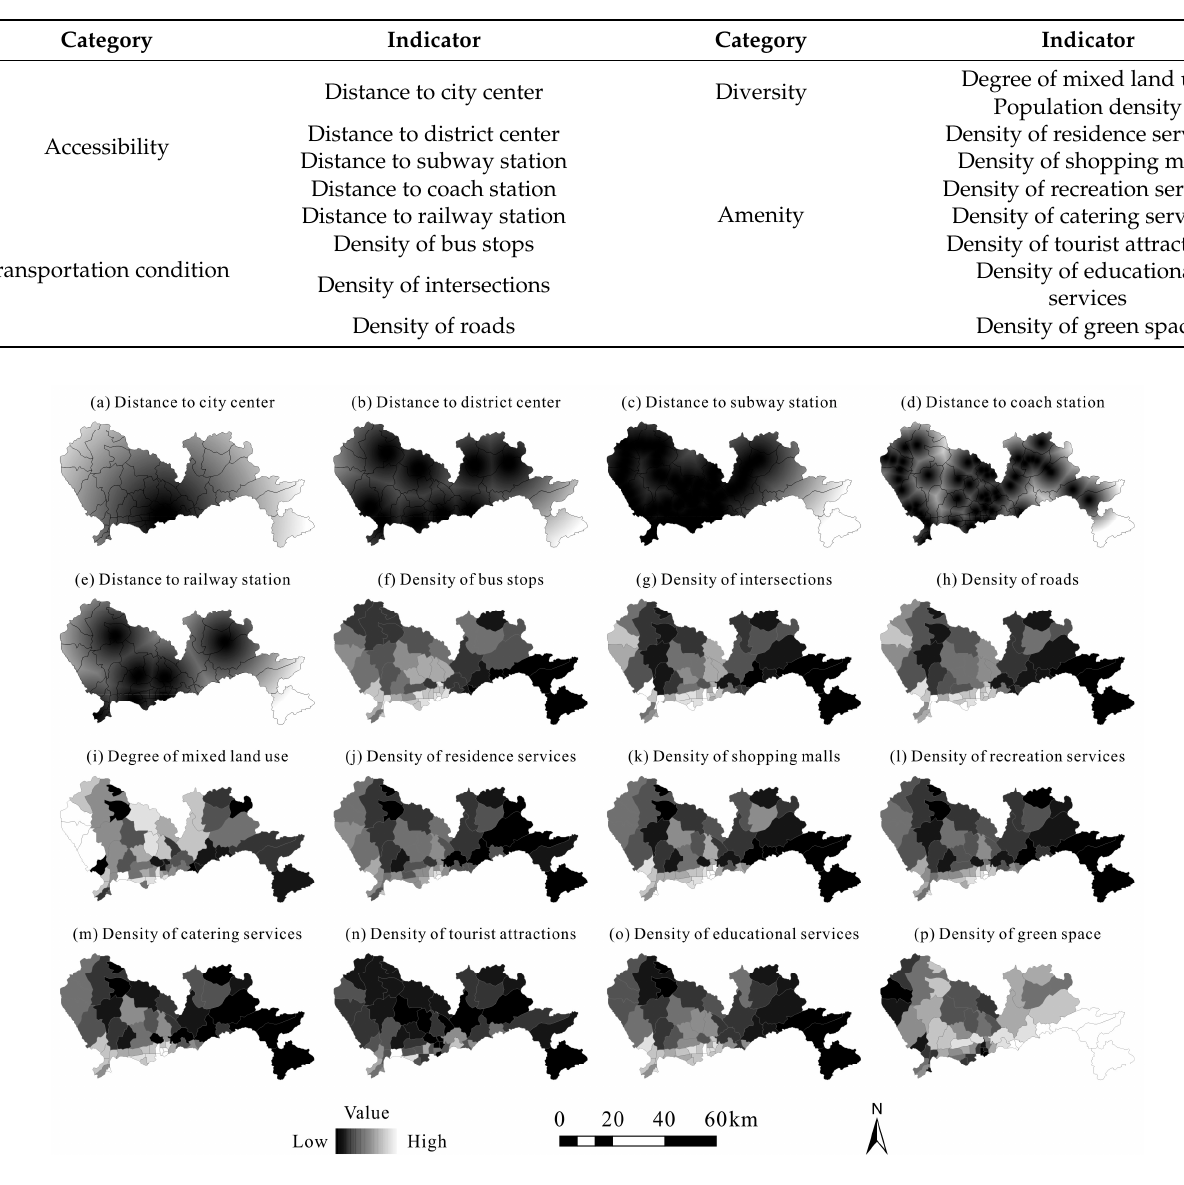
Figure 3. Benchmark spatial drivers behind urban